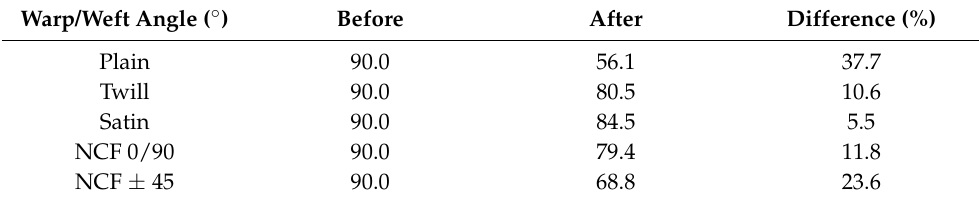
Table 3. Average warp/weft angle relation before and after deformation test.